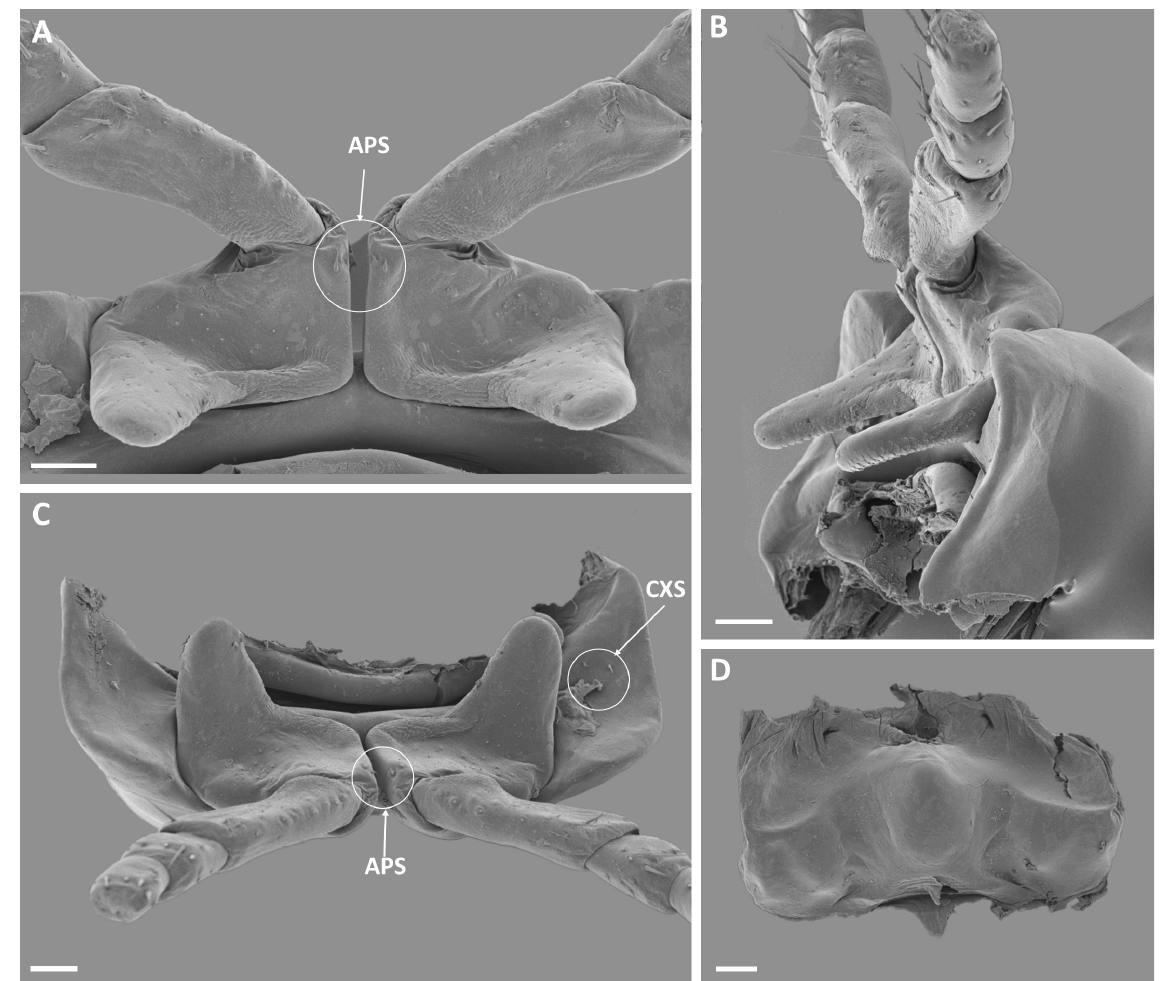
Fig. 47. Notogallanus mastacembalus gen. et sp. nov., holotype, ♂ (VMNH110632). A–C . First pair of legs. A. Anterior view. B. Sublateral view. C. Ventral view. D . Sternum 9. Abbreviations: APS = mesapical prefemoral setae; CXS = coxosternal setae. Scale bars = 0.1